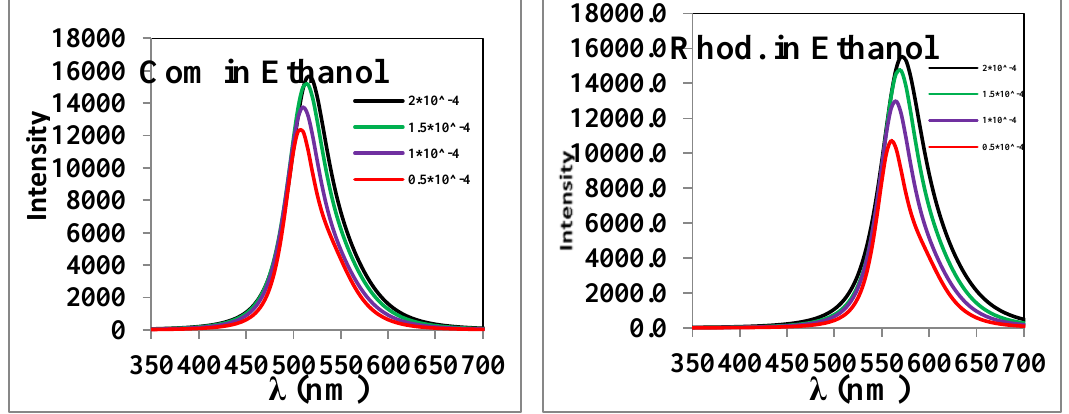
Fig. 5: The fluorescence spectrum of (a) Coumarin 334 (b) Rhodamin 590 dye solution.